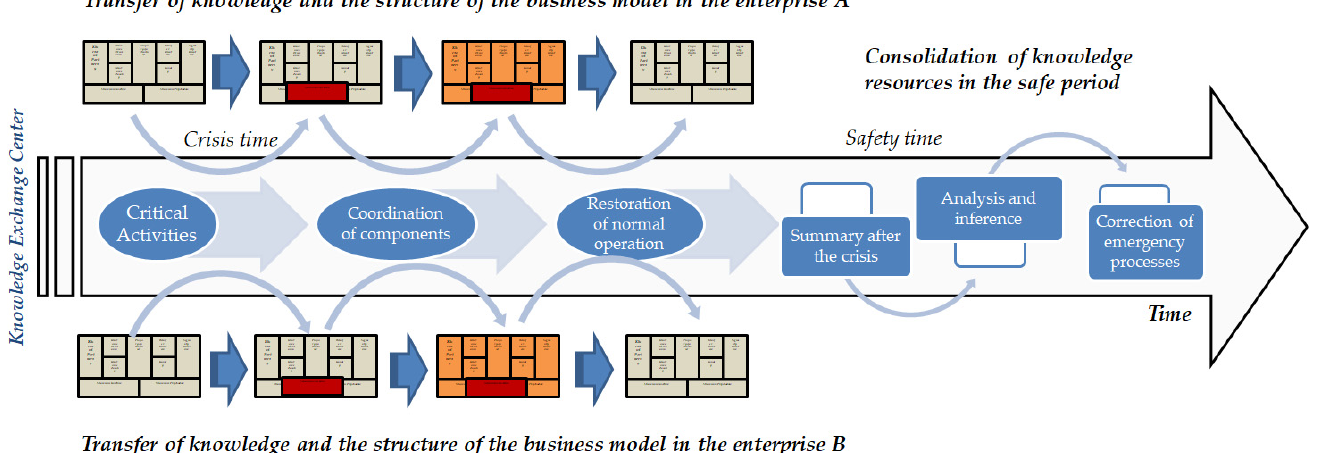
Figure 4. Knowledge transfer of tourism enterprises as part of cooperation with the knowledge exchange center. Source: own study.